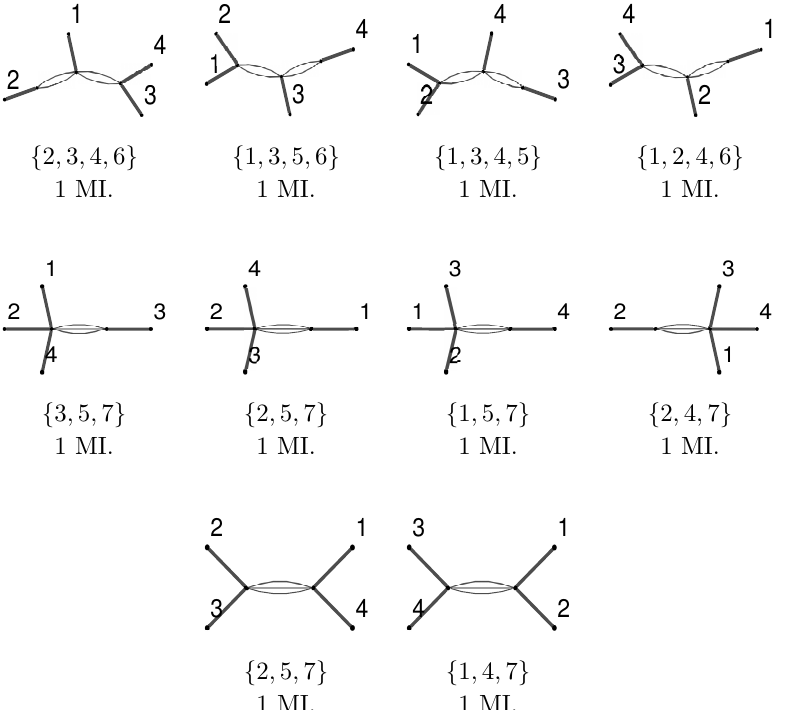
Figure 3. Diagrams for the two-loop master integrals with four external massive